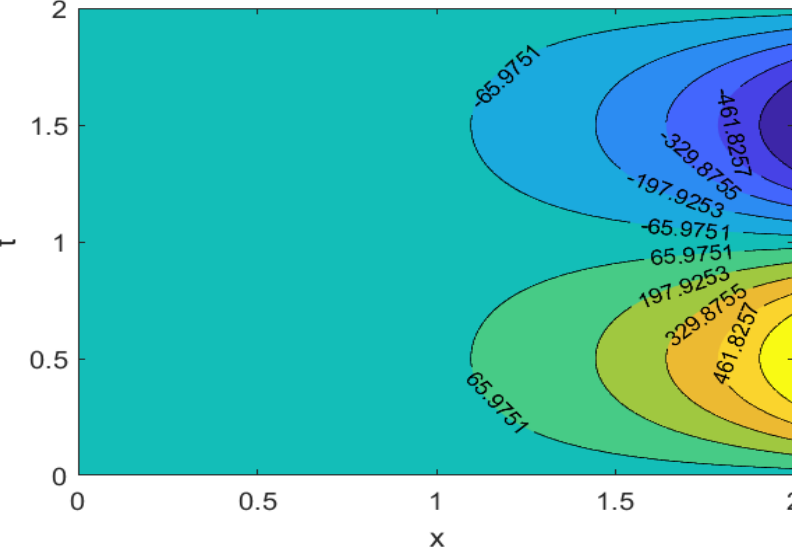
Figure 5. Contour plot of w h ( x , t ) for α = 1.3, T = 2, L = 2, M = N =